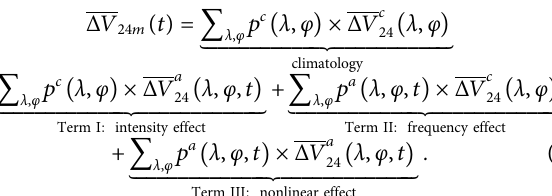
Frontiers in Earth Science |